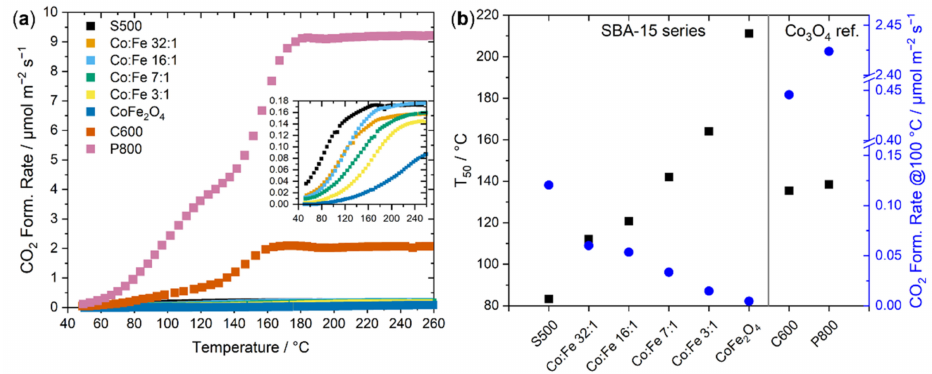
Figure 3. ( a ) Temperature-programmed CO oxidation rates of the investigated catalysts in the 1st run. SBA-15-templated Fe incorporation series is shown as a zoom-in insert for better visibility. ( b ) Temperature-programmed CO oxidation activity of the different Co oxide samples in the 1st